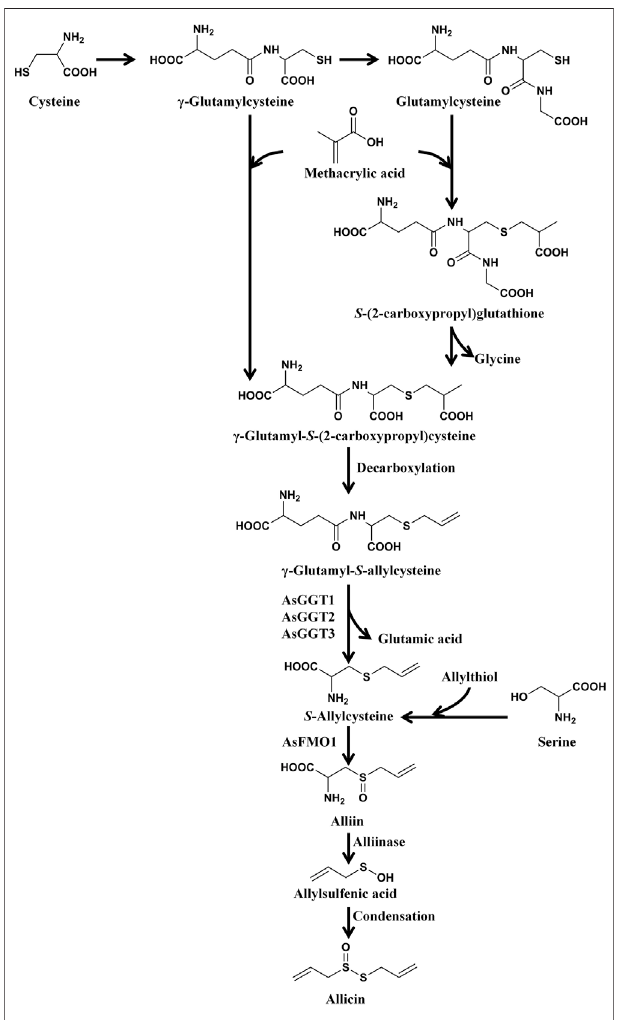
FIGURE 2 | The synthesis process of alliin and allicin. Cysteine fi rst synthesizes γ -glutamylcysteine and glutamylcysteine, and then the two compounds react with α -methacrylic acid, and synthesize γ -glutamyl- S (-2- carboxypropyl) cysteine and S -(2-carboxypropyl) glutathione, respectively. Subsequently, S -(2-carboxypropyl) glutathione also forms γ - glutamyl- S (-2-carboxypropyl) cysteine. Then γ -glutamyl- S -(2-carboxypropyl) cysteine undergoes decarboxylation and form γ -glutamyl- S -allylcysteine. γ - Glutamyl- S -allylcysteine fi rst undergoes deglutamylation to produce S -allylcysteine (catalyzed by recombinant AsGGT1, AsGGT2, and AsGGT3), and then undergoes S -oxygenation (catalyzed by recombinant AsFMO1) to producealliin. S -allylcysteinecanalsobeenproducedbytheprocessofserine reacting with allylthiol. After synthesis, alliin is further decomposed into allylsulfenic acid under the catalysis of alliinase, and then the two molecules of allylsulfenic acid condense spontaneously to produce one molecule of allicin. (Rose et al., 2005; Yoshimoto and Saito, 2019).